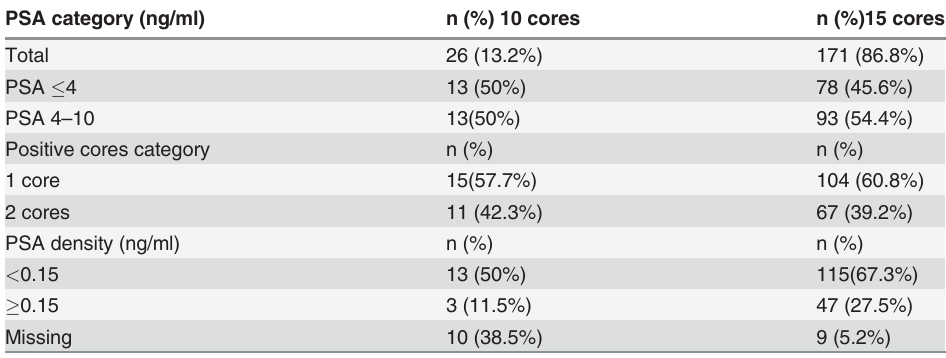
Table 7. Patient characteristics sub-analyzed according to biopsy cores (10 cores versus 15 cores), Statistics: descriptive.